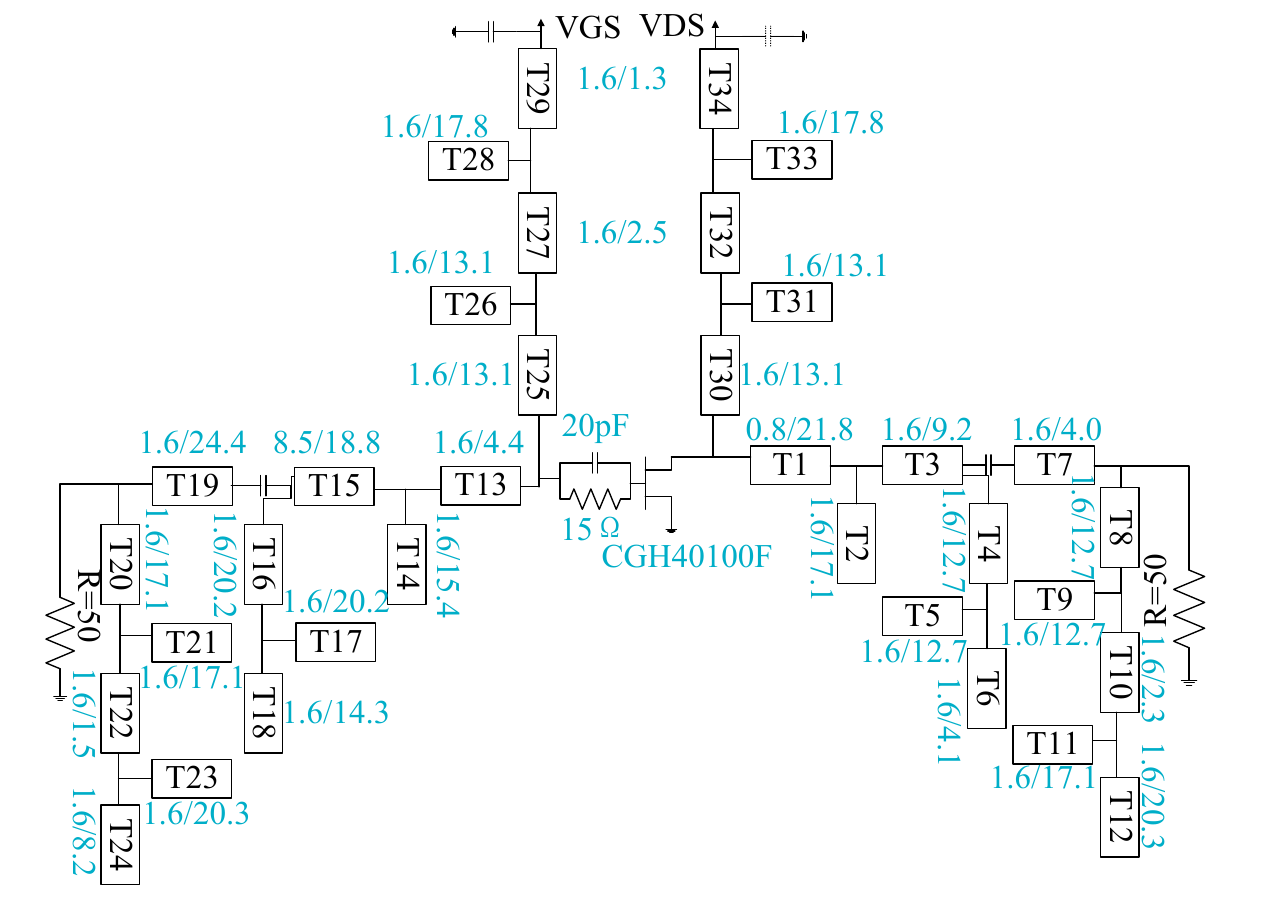
Figure 6. Overall power amplifier topology. * dimension: width/length (mm).